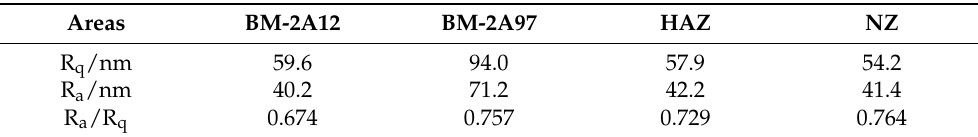
Figure 2. AFM images of the CSA film on different FSW joint areas. ( a ) HAZ, ( b ) NZ, ( c ) BM-2A12 and ( d ) BM-2A97. Table 3. Roughness of the CSA film on different areas of the FSW joint (R q : r.m.s roughness, R a : mean roughness).